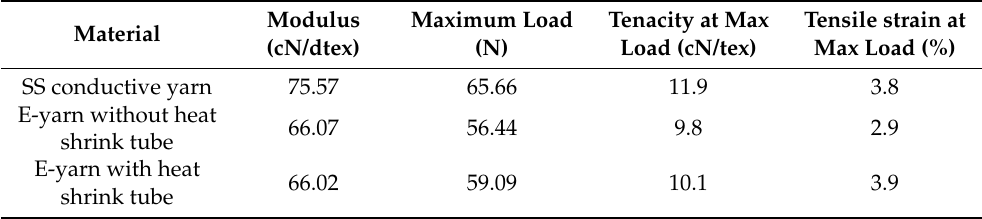
Table 6. Strength characteristics of SS conductive yarn and E-yarn.